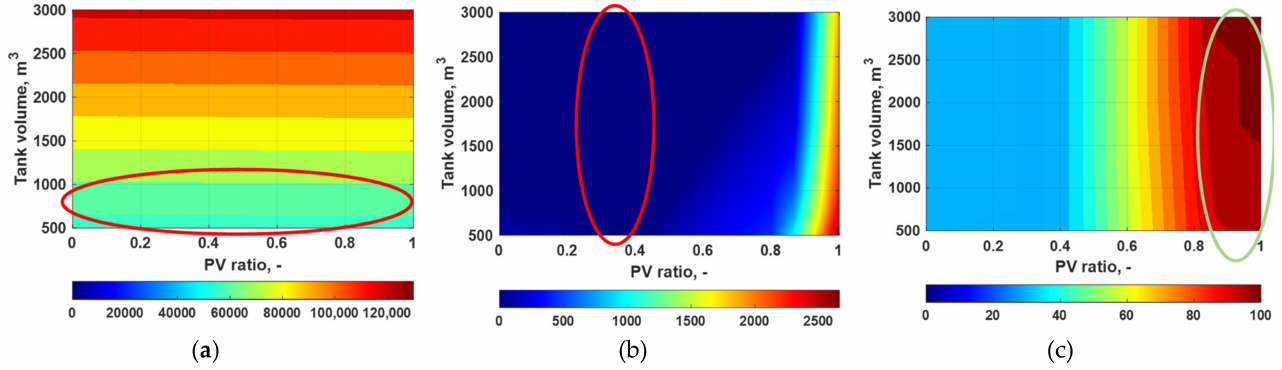
Figure 9. Variation of the optimization criteria for a cherry crop in Kyustendil for a 15 kW hybrid system with mSi PV panels and WT type 1 without a battery: ( a ) investment cost IC ($); ( b ) wasted electrical energy WEE (kWh); ( c ) satisfaction of the crop’s requirement SCR